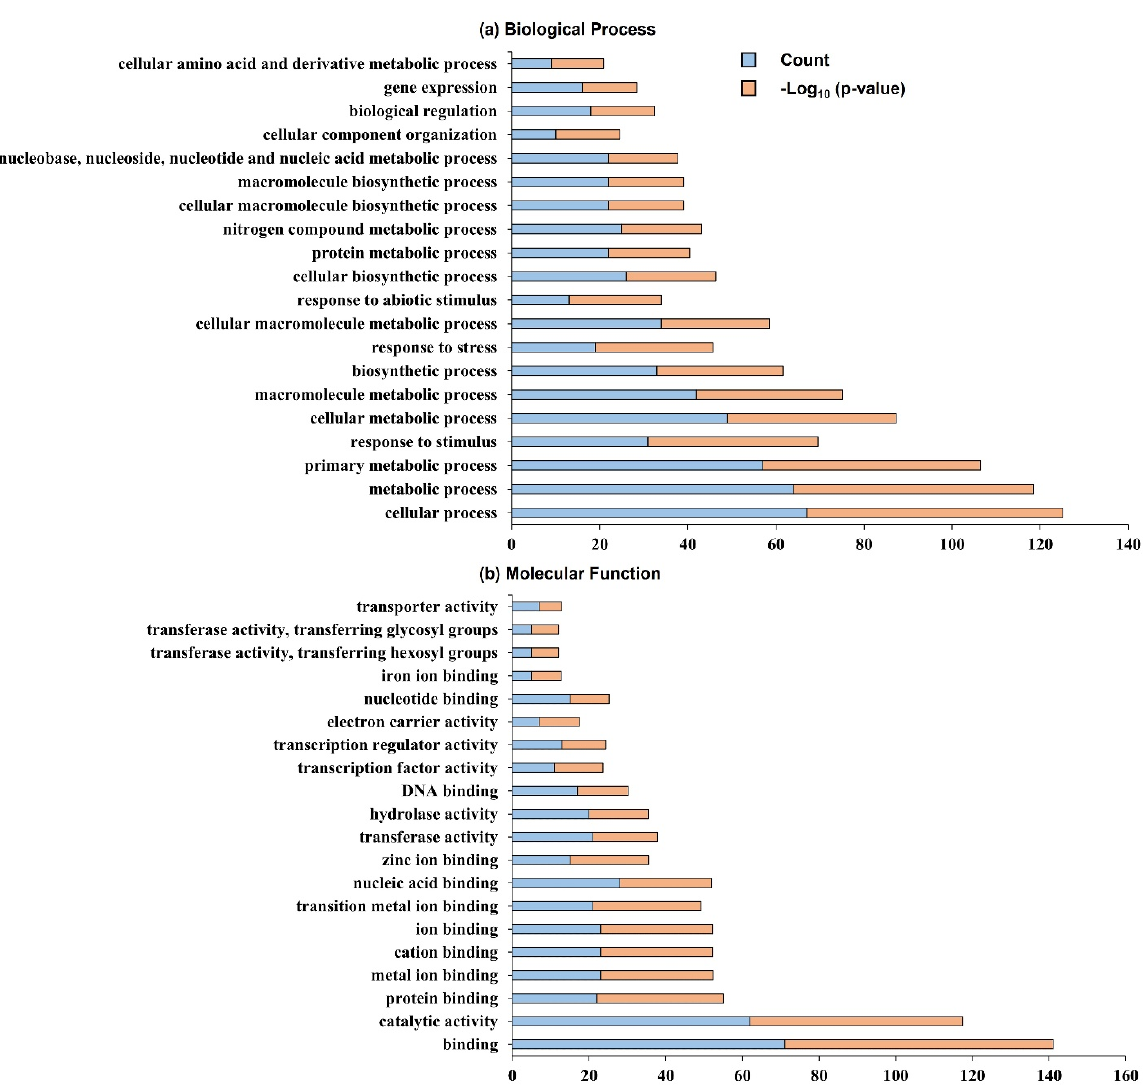
Figure 4. Gene ontology annotation of the QTL target locus RM6235–RM24288 on chromosome 9. ( a ) The 20 top ‐ ranking GO terms for Biological Process. ( b ) The 20 top ‐ ranking GO terms for Molec ‐ ular Function. ( c ) The 10 top ‐ ranking GO terms for Cellular Component.